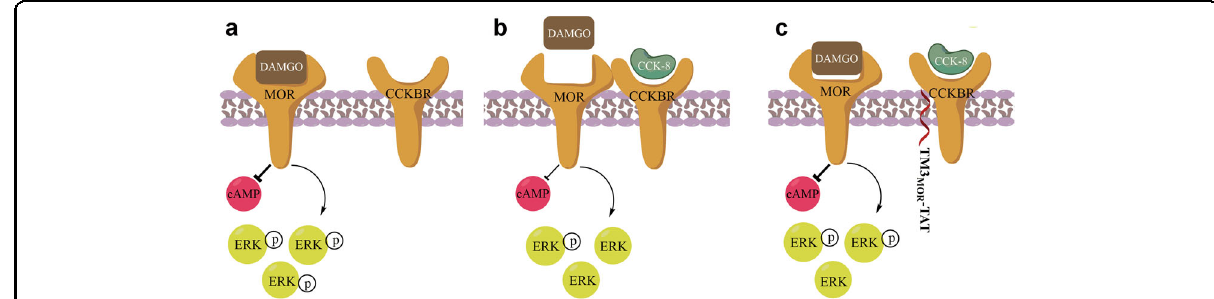
Fig. 8 Schematic diagram: MOR – CCKBR heteromerization antagonizes MOR activity and morphine analgesia. a When MOR is not heteromerized with CCKBR, MOR has high binding af fi nity with its agonist DAMGO (shown here as an example) and highly activates signal transmissions, such as strong DAMGO-induced ERK1/2 phosphorylation and inhibition of cAMP accumulation. b When MOR directly forms heteromers with CCKBR, the ligand-binding af fi nity of MOR is decreased, and agonist-induced ERK1/2 phosphorylation and cAMP inhibition are diminished, exhibiting CCK-8 antagonism to morphine analgesia. c Disruption of the heteromerization of MOR – CCKBR with TM3 MOR -TAT treatment enhances the activities of the MOR and thus improves the analgesic effects of μ -opioid agonists such as DAMGO or